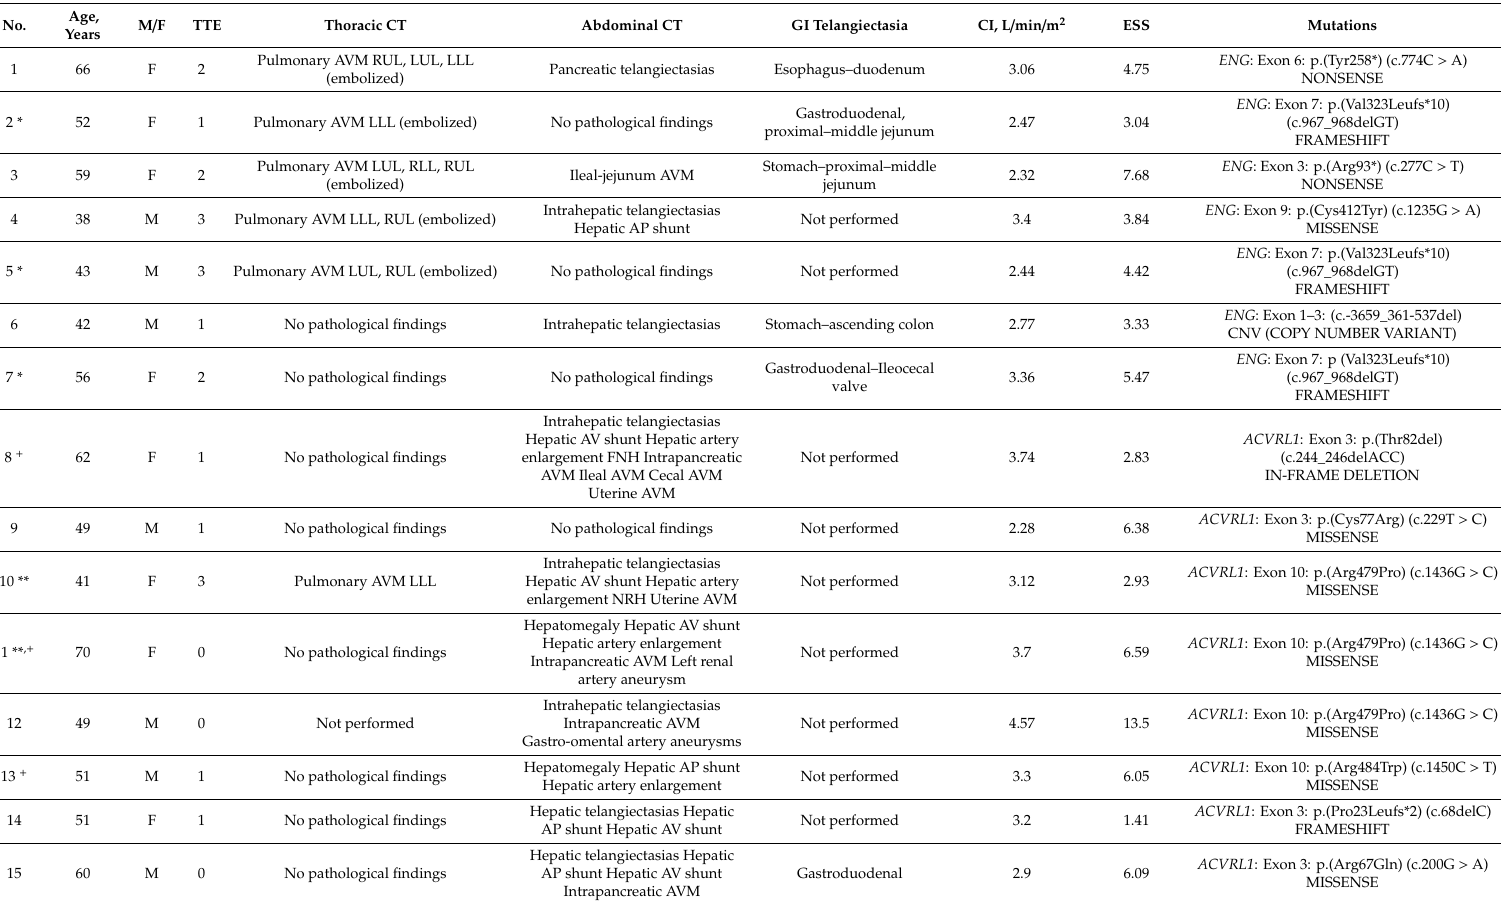
Table 1. Hereditary hemorrhagic telangiectasia type 1 and 2 patient